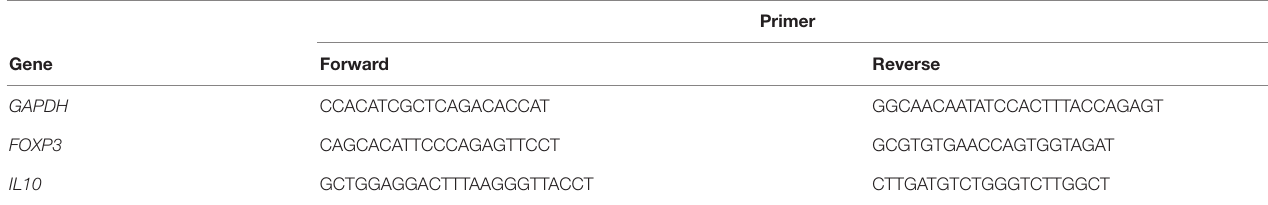
Sequences are shown in the 5 ′ –3 ′